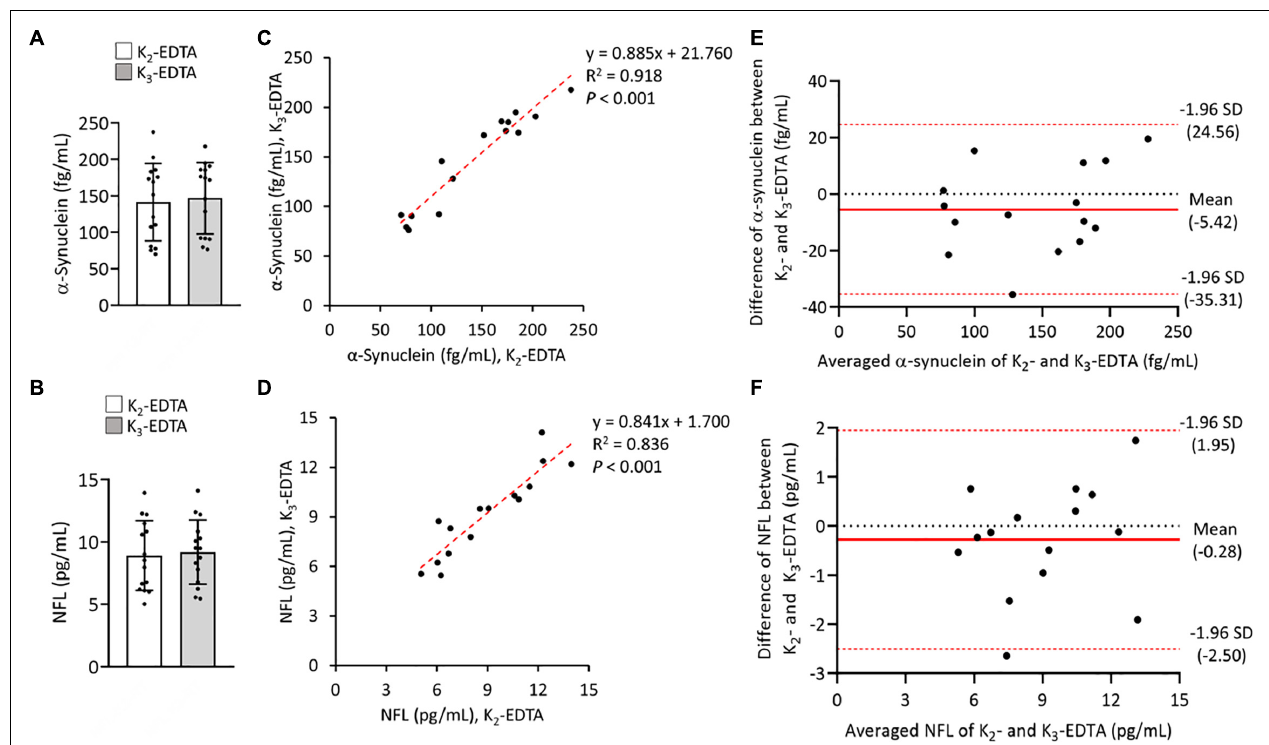
FIGURE 1 | Levels of α -synuclein and neurofilament light chain (NFL) in the plasma were prepared by using different EDTA tubes. (A) Plasma levels of α -synuclein in K 2 - ( N = 15) and K 3 - ( N = 15) EDTA tubes. (B) Plasma levels of NFL in K 2 - and K 3 -EDTA tubes. (C) Correlations between α -synuclein levels in K 2 - and K 3 -EDTA tubes. (D) Correlations between NFL levels in K 2 - and K 3 -EDTA tubes. (E) Bland-Altman plot of the comparability of α -synuclein levels in K2- and K3-EDTA tubes. The red dotted lines represent limits of agreement (mean difference ± 1.96 SD ). (F) Bland-Altman plot of the comparability of NFL levels in K2- and K3-EDTA tubes. R 2 , Pearson’s correlation coefficient. Comparisons by Mann-Whitney U -test.